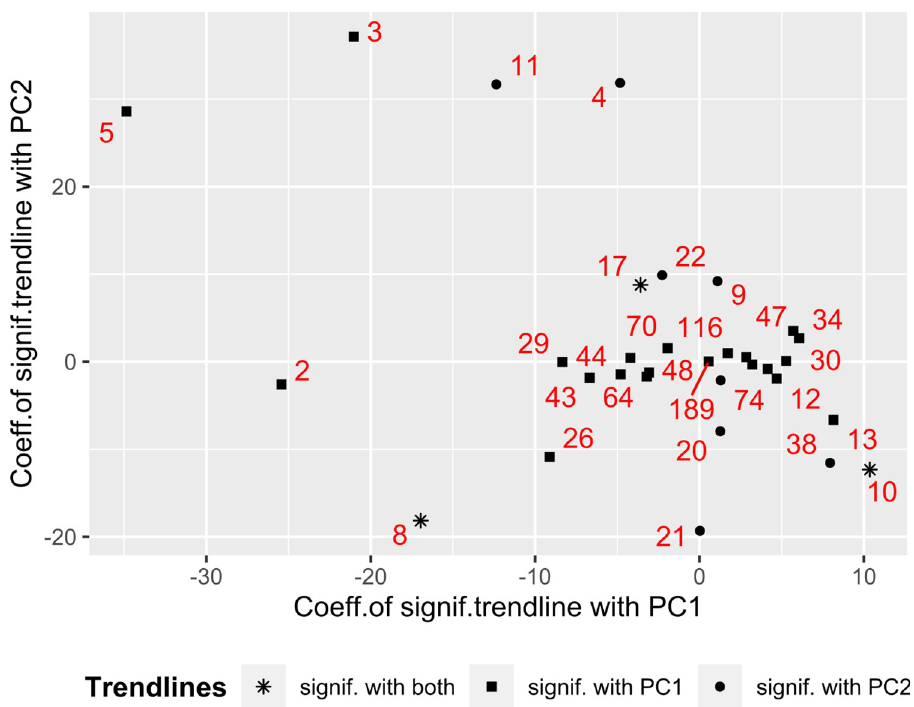
Fig 7. The summarized graph for the values of the coefficients of significant linear trends. Only taxa that have a significant trend with at least one of the components of soil properties are shown. The greater the slope coefficient of the trend, the stronger the dependence of taxon abundance on the component.